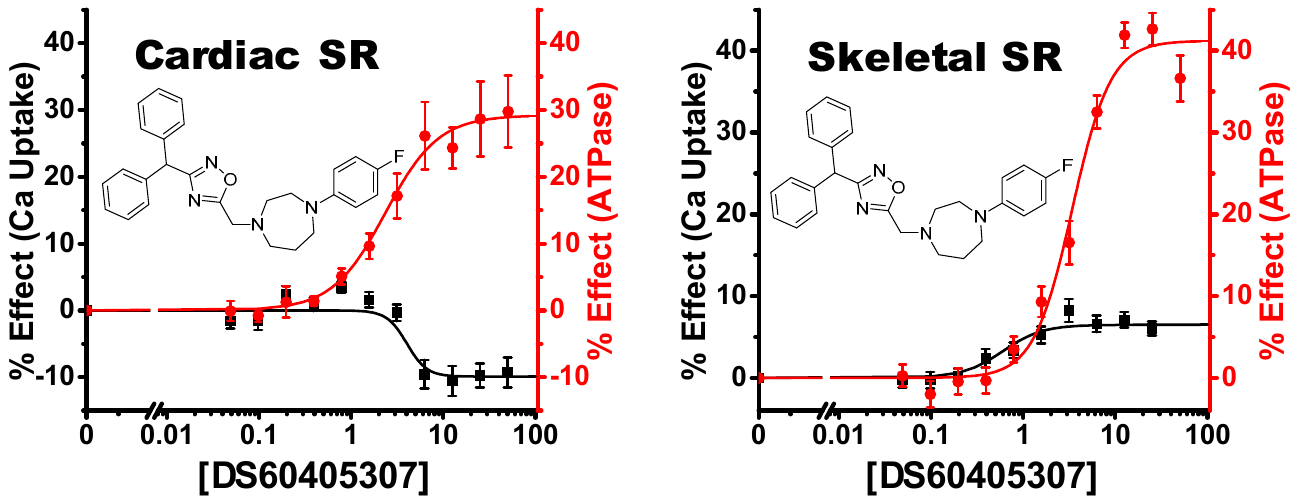
Figure 7. Isoform-specific uncoupler. Concentration response curve of compound #12 (DS60405307) shows an inhibition of Ca 2+ uptake activity despite a substantial increase in ATPase activity in cardiac SR. However, the same compound has a small but significant increase in Ca 2+ uptake activity in skeletal SR. This tissue-dependent effect is presumably due to SERCA2a (cardiac) vs. SERCA1a (skeletal) isoform differences or the presence/absence of regulators (PLB vs. SLN). n = 3, ± SEM.